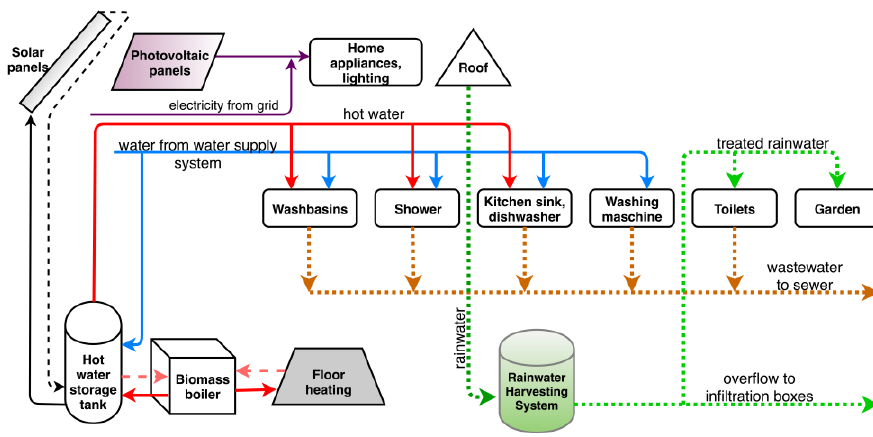
Figure 4. Diagram of system operation in Variant 1.